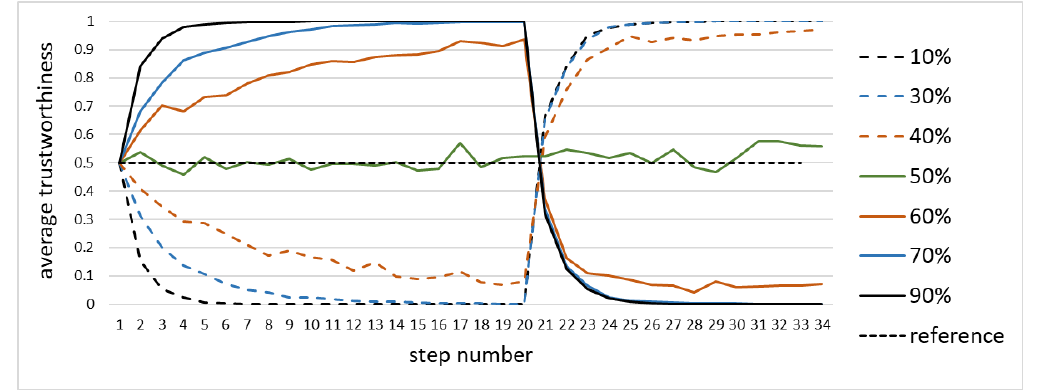
Figure 7. Response to transition as a function of the fraction of trustworthy nodes.